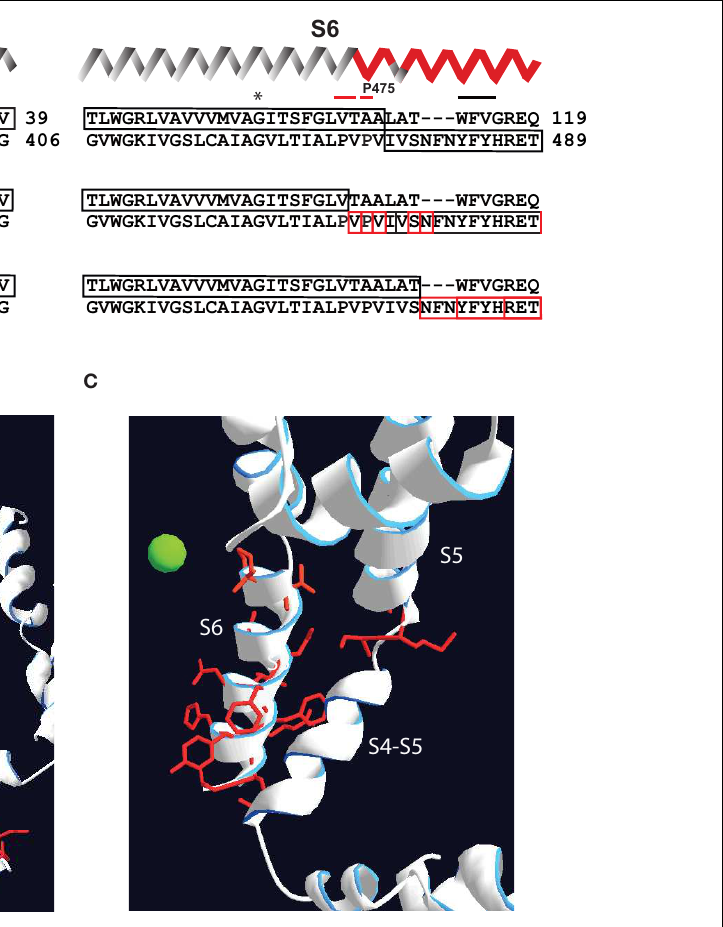
Red-framed residues indicate the extension of the chimeric link (one residue at a time) causing constitutive conductance. (B) Localization of residues susceptible for constitutive conductance mapped on crystal structure of Kv1.2–Kv2.1.The side-chains of these residues are represented as red sticks. Only one subunit is shown for simplicity. (C) Top view of same structure shown in (B)